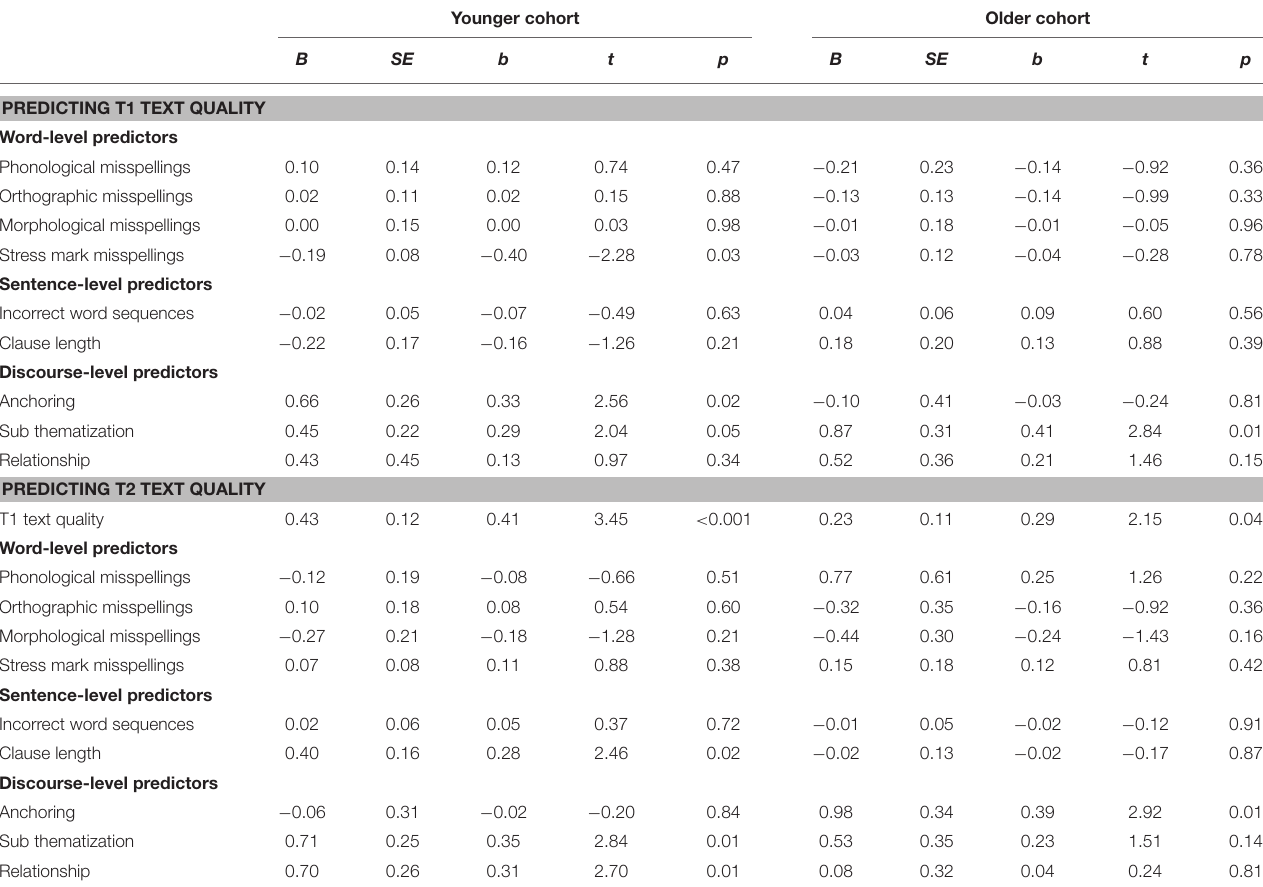
TABLE 4 | Parameter estimates of the final regression models predicting text quality at T1 and T2 for each